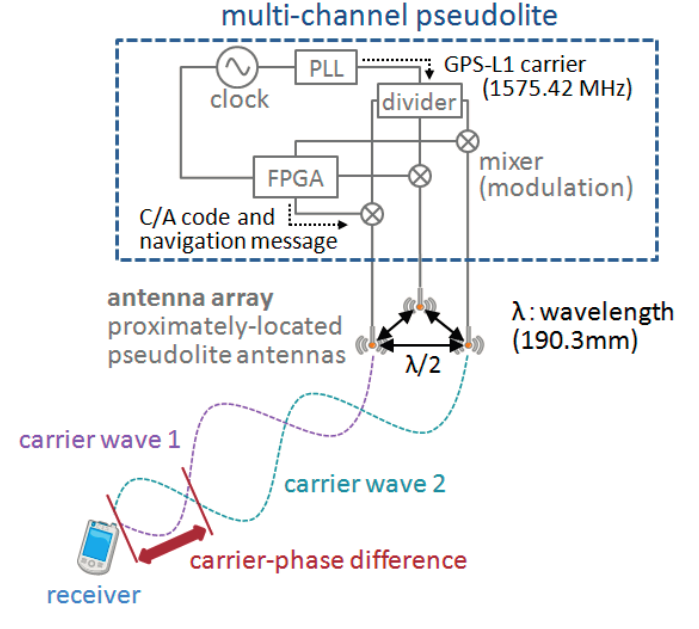
Figure 2. Overview of multi-channel pseudolite and carrier-phase difference